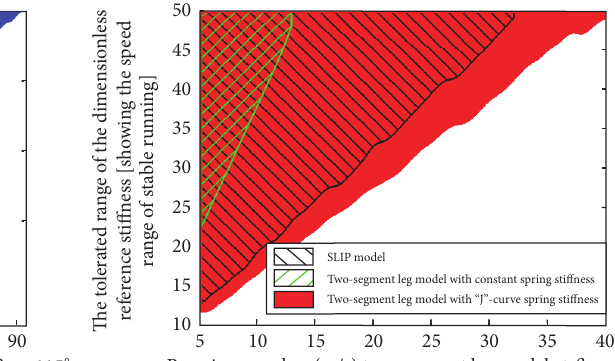
SLIP model stiffnessTwo-segment leg model with constant spring stiffness Two-segment leg model with “J”-curve spring